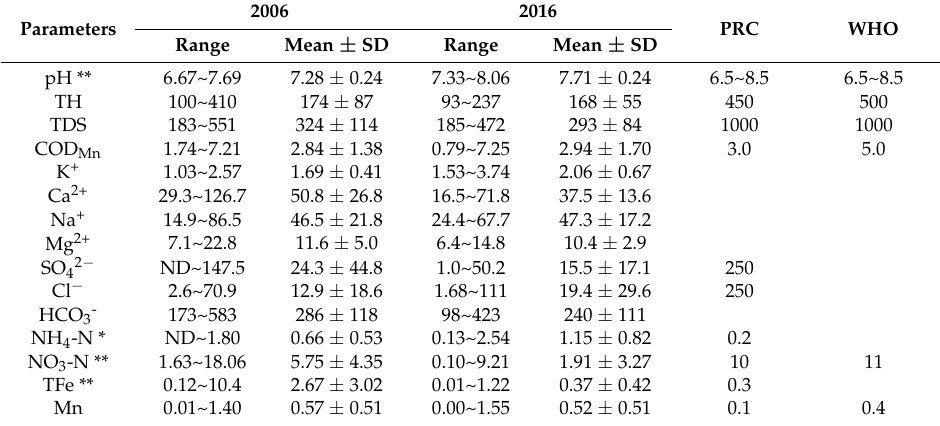
Table 4. Statistical summary of geochemical parameters and their comparison with the limits of PRC drinking water standards [42] and WHO guidelines values [43] (units =